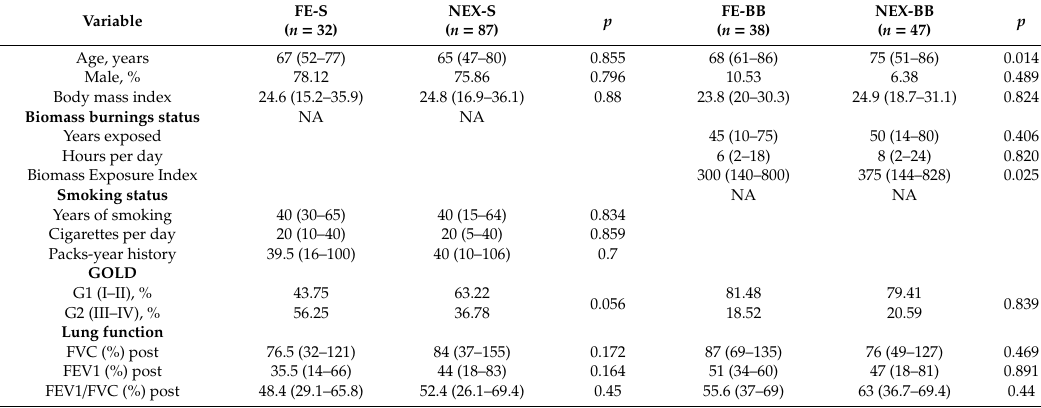
Table 2. Demographic variables among chronic obstructive pulmonary disease (COPD) patients FE-S, NEX-S, FE-BB, and